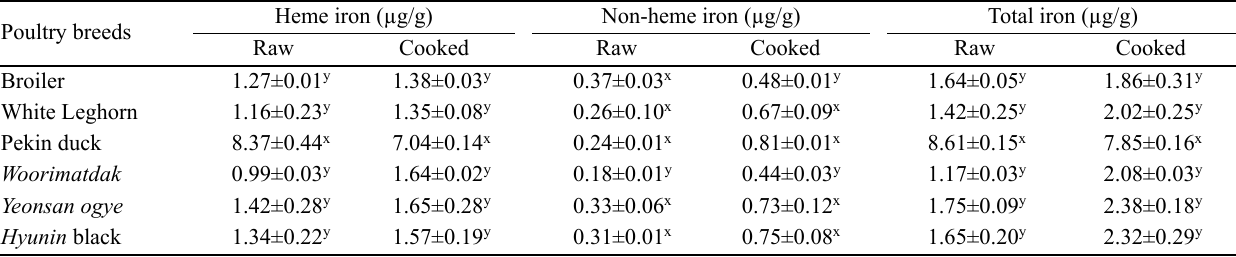
Table 3. Iron contents of raw and cooked breast meat of different breeds of poultry Heme iron (µg/g) Non-heme iron (µg/g) Total iron (µg/g) Poultry breeds Raw Cooked Raw Cooked Raw Cooked Broiler